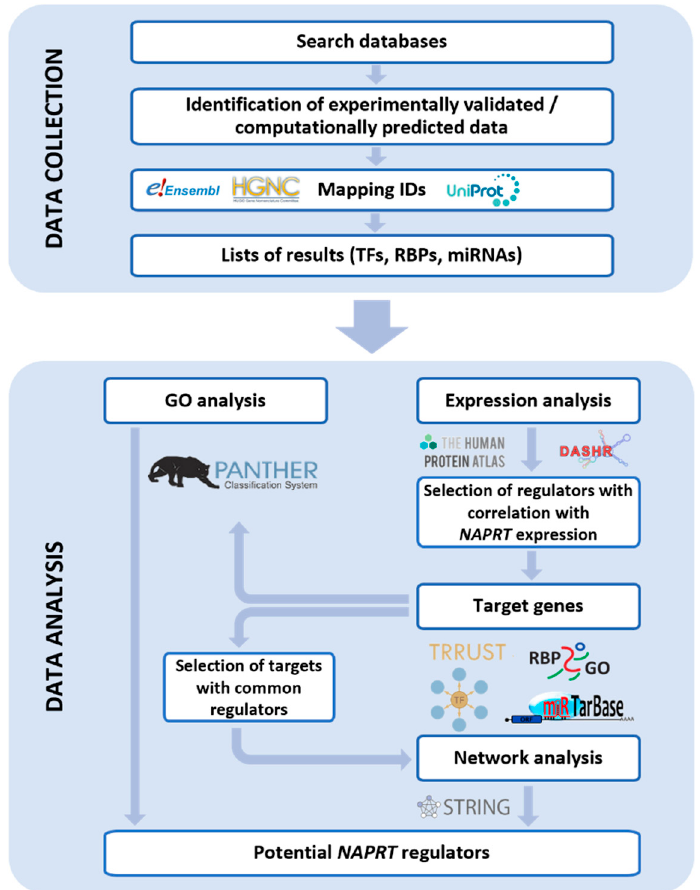
Figure 1. Data analysis. Schematic representation showing the pipeline followed to collect and analyze nicotinate phosphoribosyltransferase ( NAPRT ) putative binding transcription factors (TFs), RNA binding proteins (RBPs) and microRNAs (miRNAs). The list of databases can be found in Supplementary Table S1.